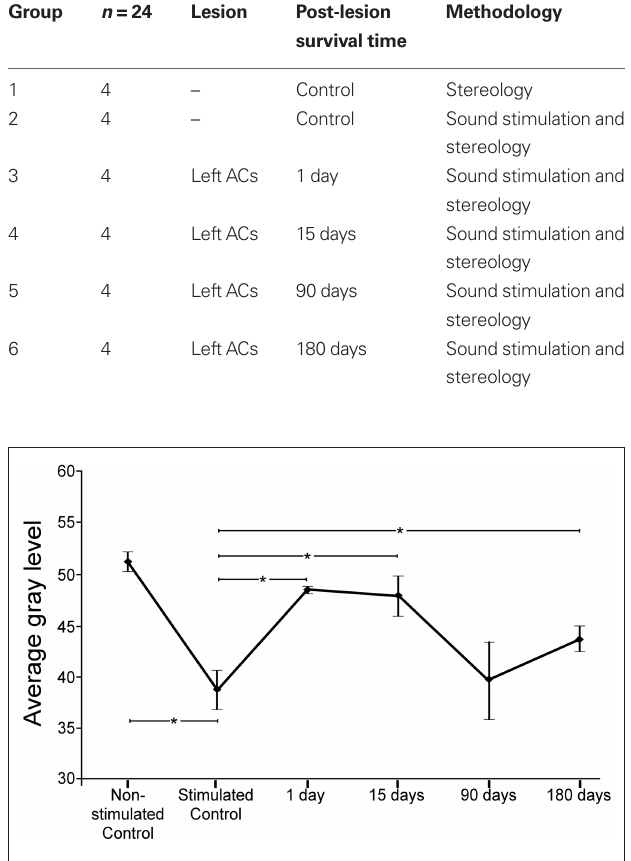
Figure 2 | Average gray levels of sound-induced c-Fos immunoreactivity in nuclei of the inferior colliculus at different times after a unilateral cortical lesion. In control non-stimulated groups, means were higher (i.e., shifted toward lighter gray levels) than in the stimulated control. Comparisons between stimulated controls and lesioned stimulated groups shows that the average levels shift toward values closer to the white side of the gray range at 1 and 15 days after the lesion. Ninety and 180 days after the lesion, gray values return to levels comparable to controls. The asterisks show the significant differences (average ± 2SD) between both, the non-stimulated control and the group of stimulated control, and the stimulated control group and lesioned